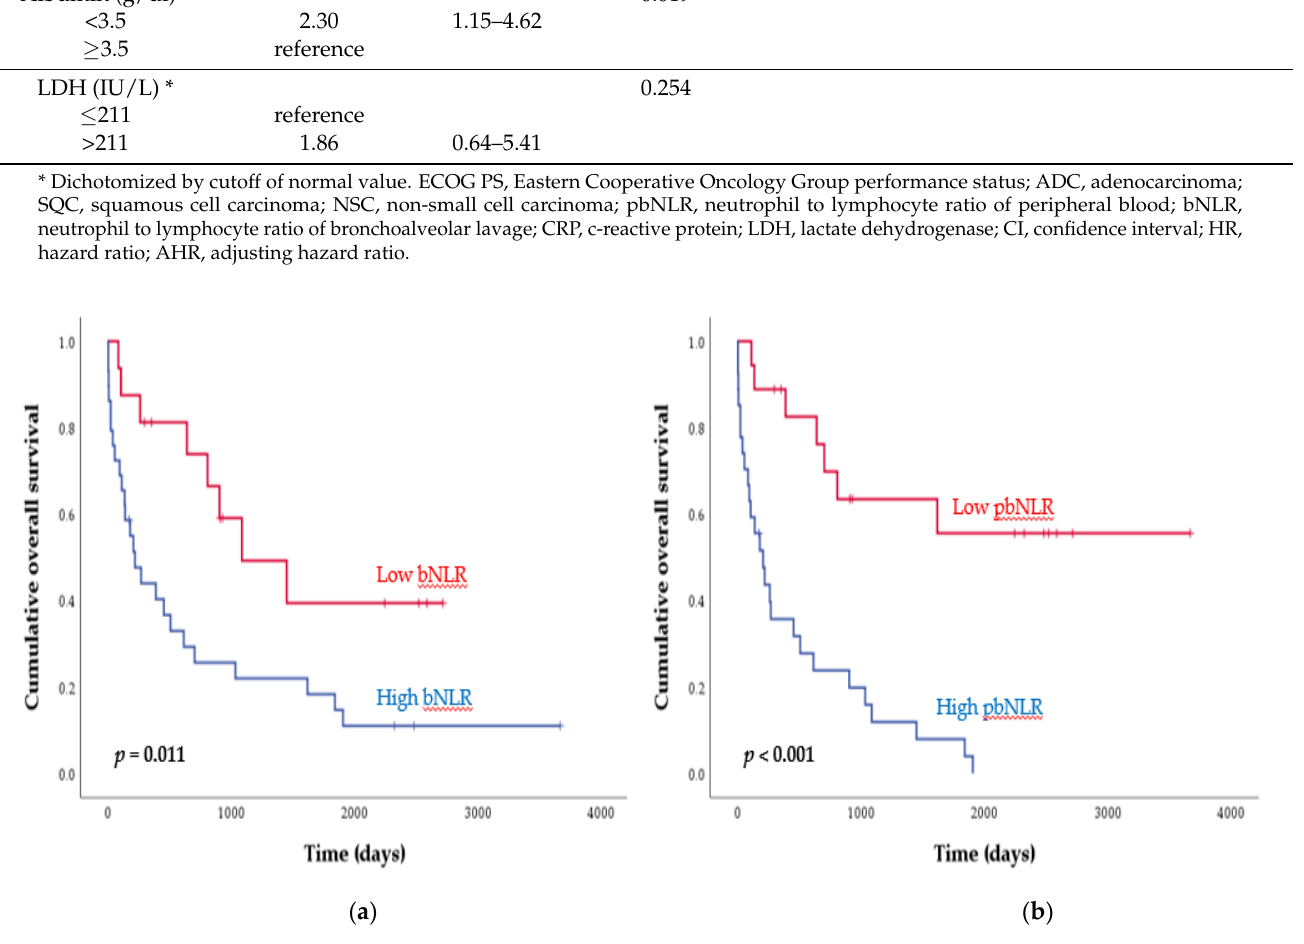
Figure 2. Kaplan–Meier curves of overall survival according to ( a ) the neutrophil-to-lymphocyte ratio in BAL fluid (bNLR), and ( b ) the neutrophil-to-lymphocyte ratio in peripheral blood (pbNLR).